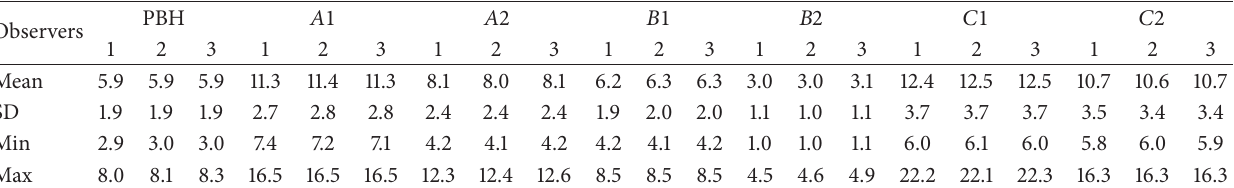
Table 1: Measurements on CBCT images of the observers.